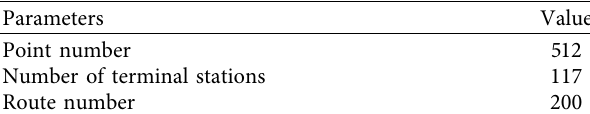
Table 2: Attribute